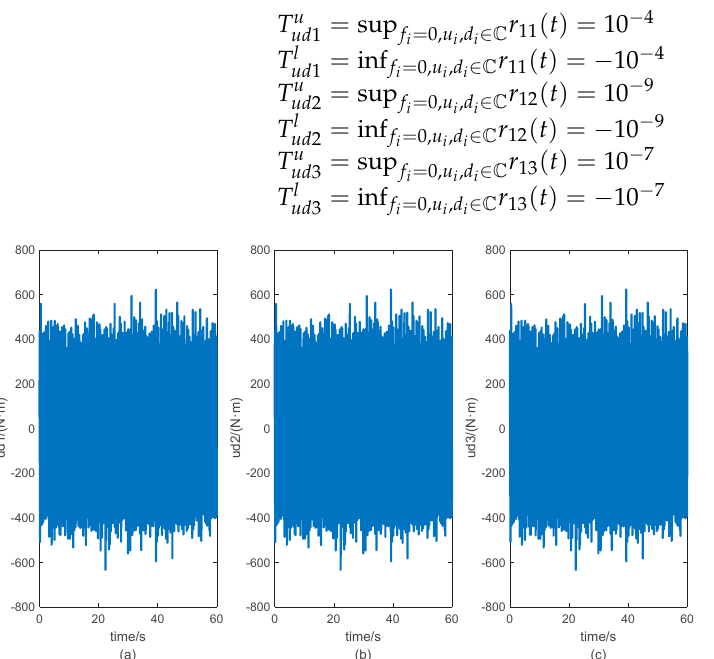
Figure 4. Curves of the disturbances. ( a ) Curve of disturbance input of Agent 1. ( b ) Curve of disturbance input of Agent 2. ( c ) Curve of disturbance input of Agent 3.